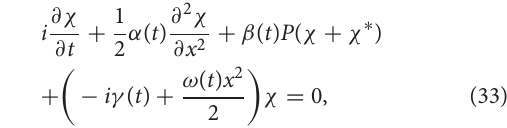
0.5cos t ) and α + exp(0.05 =